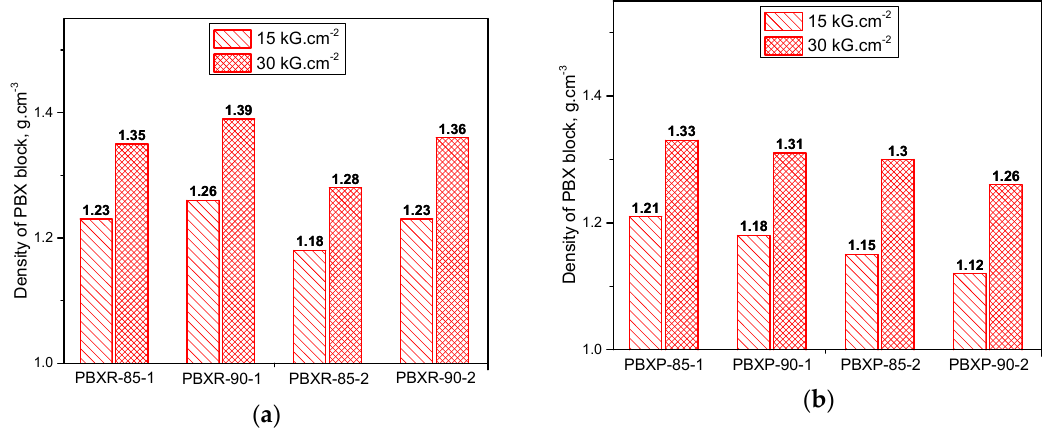
Figure 5. ( a ) Interfacial tension and ( b ) Work of adhesion of explosives and several binders.